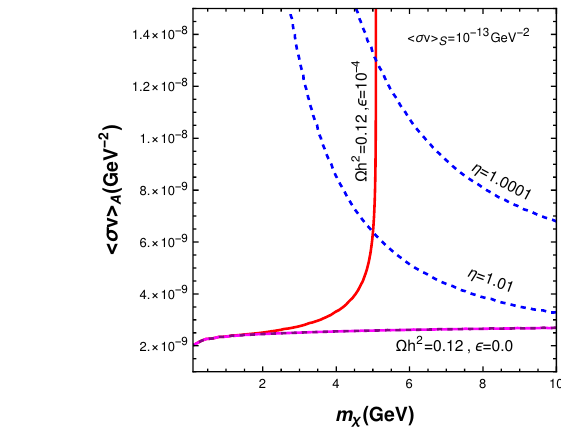
(cid:27)v as a function of the DM h i A (cid:27)v h i S